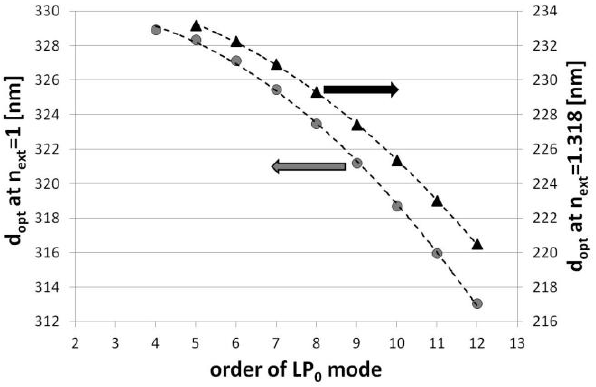
Figure 5. Calculated d of the cladding modes and the LPG is surrounded by air ( n ( n = 1.318 ext